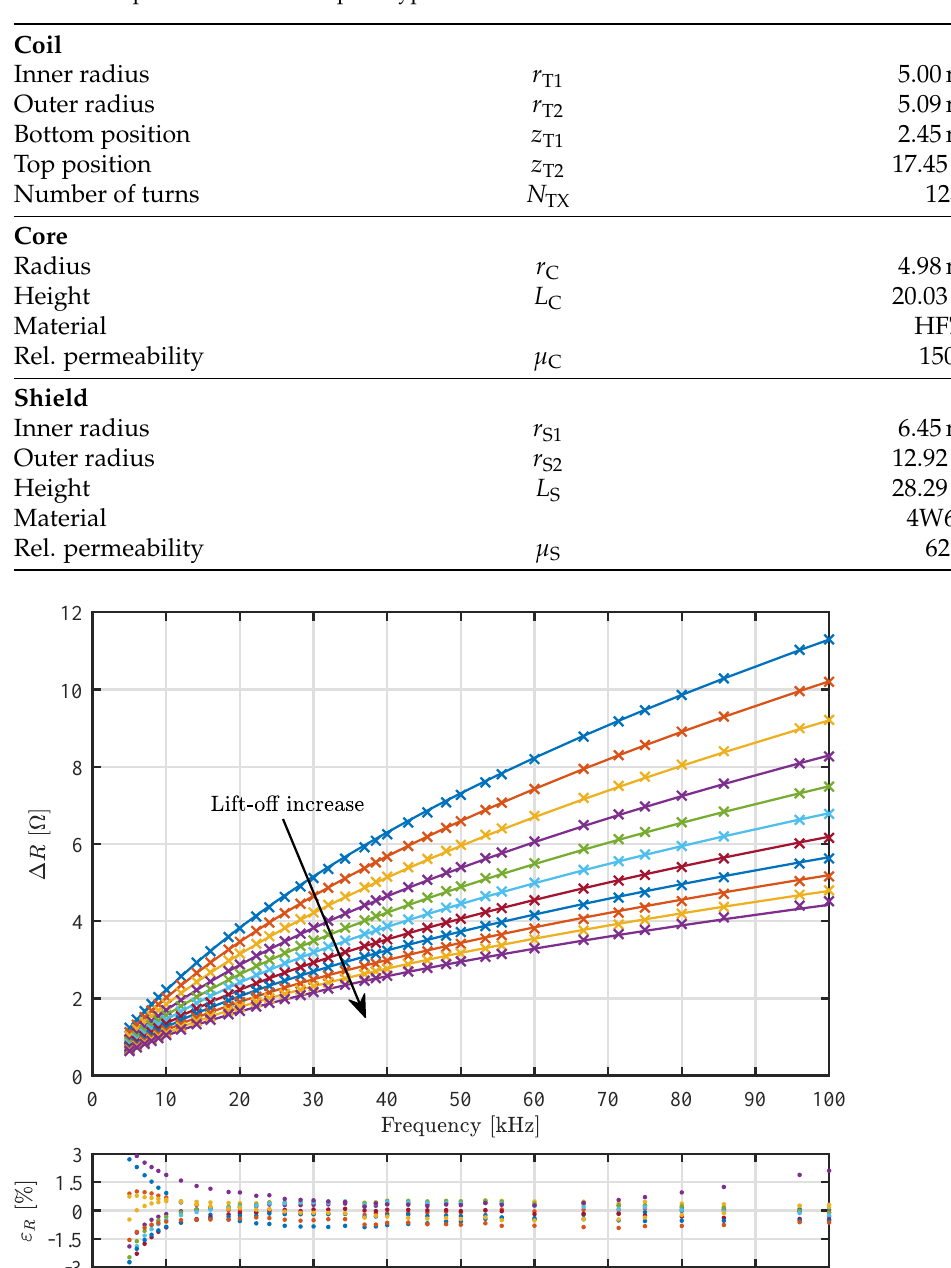
Figure 6. Real part ∆ R of impedance change ∆ Z . Full lines are modeling results and crosses are measured values. The top curve is for lift-off 0µm and the bottom curve for 1000µm. Other curves are in 100µm increments. The graph bellow shows error ε R of individual measurement data points relative to the model